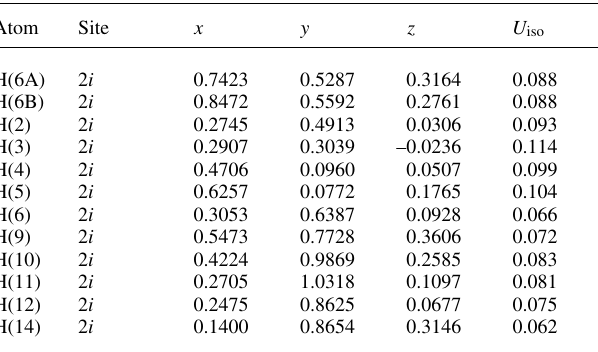
Table 2. Atomic coordinates and displacement parameters (in Å 2 )